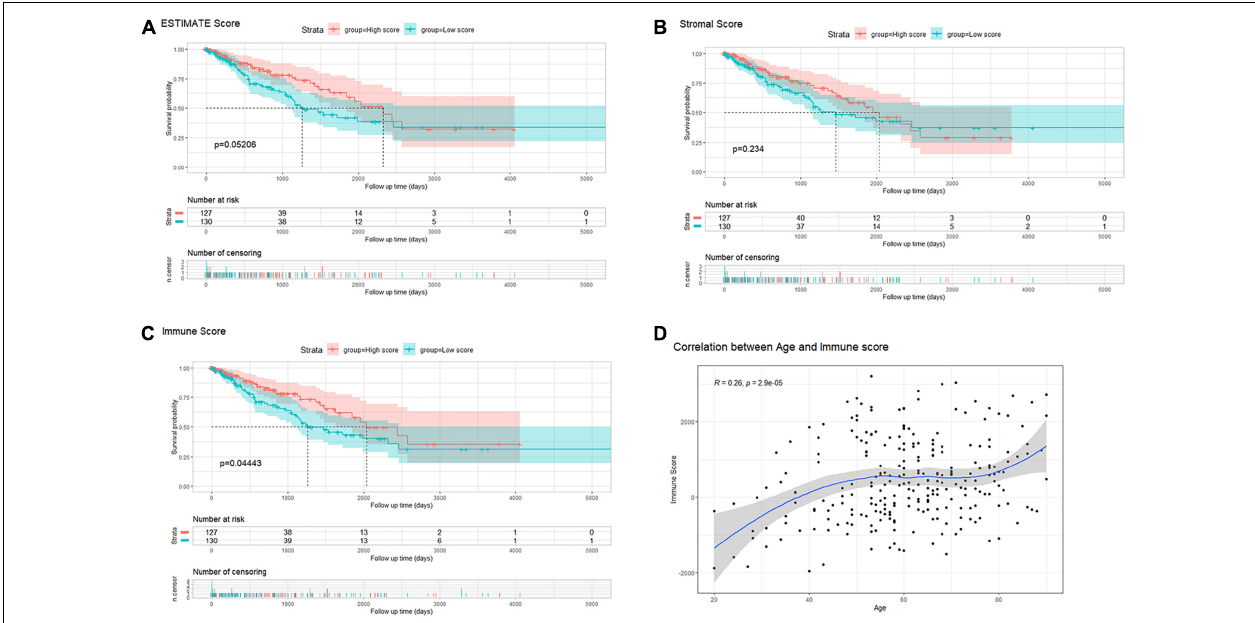
FIGURE 2 | (A–C) Kaplan–Meier survival analysis of sarcoma patients’ overall survival according to scores calculated by the ESTIMATE algorithm: ESTIMATE (tumor purity), stromal cell infiltration, and immune cell infiltration. (D) The correlation between immune scores and the age of diagnosis in patients with sarcoma.